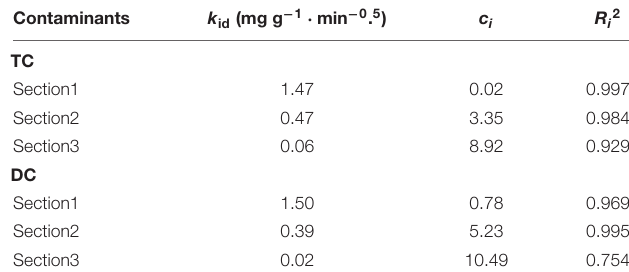
TABLE 5 | Intra-particle diffusion parameters for the adsorption of TC and DC by BC/MnO 2 . Contaminants